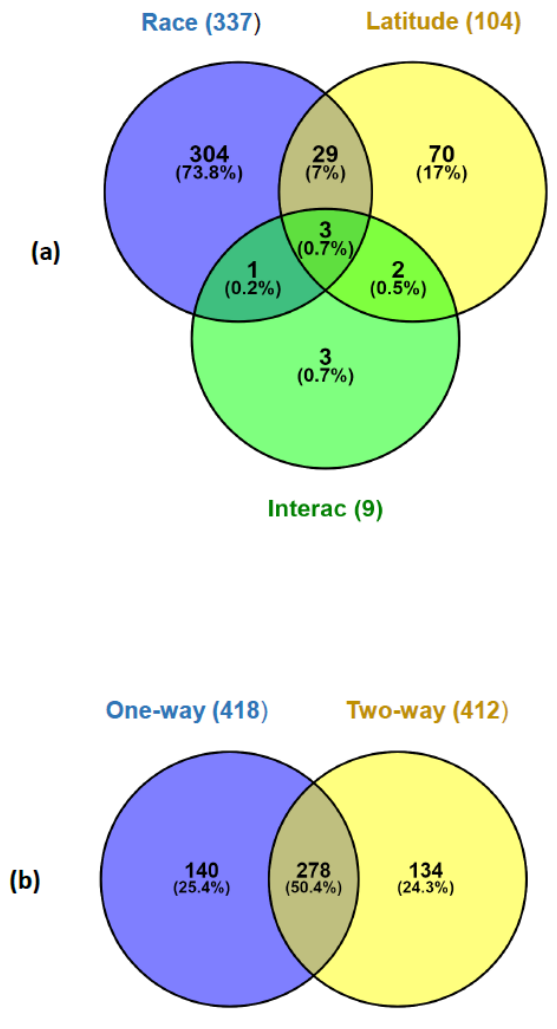
Figure 5. Venn diagrams showing the number of DEGS (FDR = 0.05) of gene expression data. ( a ) two-way ANOVA (Race x Latitude). ( b ) Comparison of the DEGs between one-way and two-way ANOVAs.